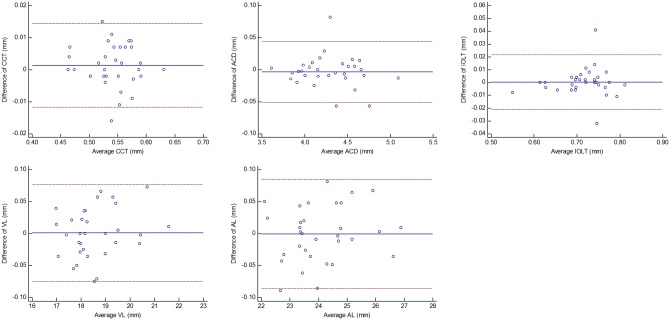
Bland-Altman plots of the difference between the two repeated measurements of full-eye axial biometry in 32 pseudophakic eyes.The full-eye axial biometry included (upper left) the central corneal thickness (CCT), (upper middle) the anterior chamber depth (ACD), (upper right) the IOL thickness (IOLT), (lower left) the vitreous length (VL), and (lower middle) the axial length (AL). Values on the horizontal axis correspond to the mean of the 2 measurements. Values on the vertical axis correspond to the difference of 2 measurements. Solid lines and dashed lines indicate mean differences and 95%limits of agreement.